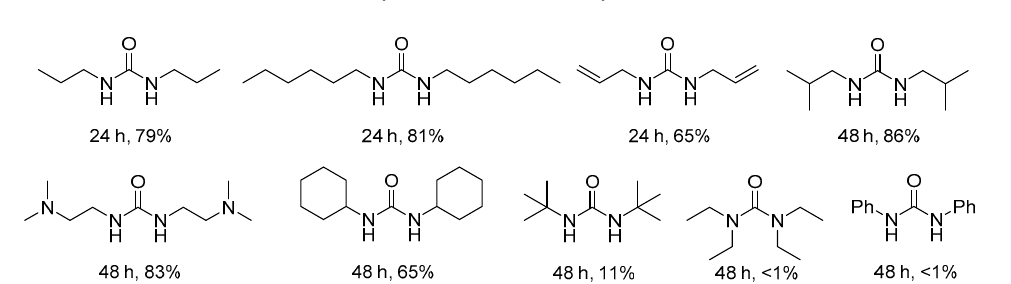
Table 3. Metal-catalyzed carbonylation of amines and CO 2.